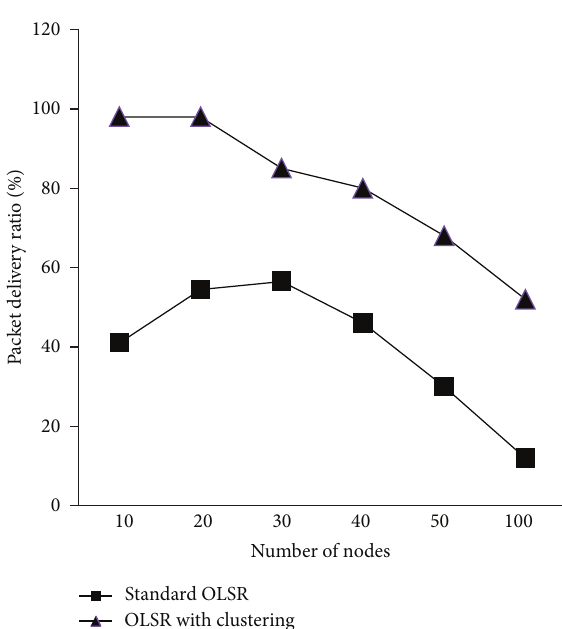
Figure 7: Packet delivery ratio versus number of nodes (CBR